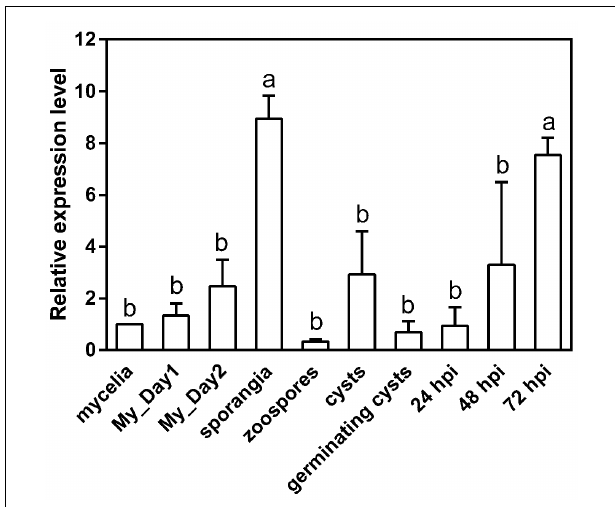
FIGURE 2 | Expression of PpMID1 is highly induced in the sporangia of Phytophthora parasitica and in planta . qRT-PCR of total RNA from different life stages of P. parasitica and 5-week-old Nicotiana benthamiana leaves inoculated with P. parasitica . Raw data were normalized to the transcript level of WS21 as an internal control and shown as fold change relative to that of mycelium. Data are mean ± SD from 3 independent experiments. Different letters indicate significant difference by Fisher’s least significant difference test ( P < 0.05). “My_Day1” and “My_Day2” indicate mycelia harvested at 1 and 2 days, respectively, after light treatment for inducing sporangium formation. hpi: hours post-inoculation.